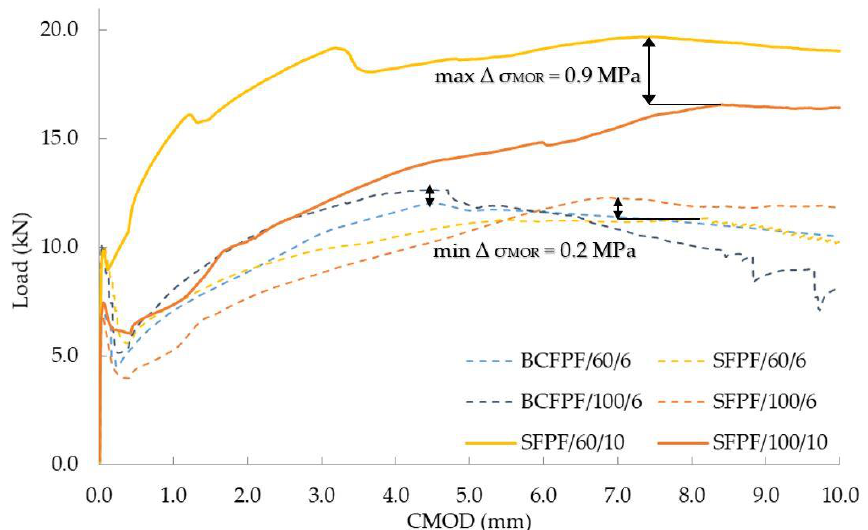
Figure 13. Load—CMOD (crack mouth opening displacement) relationship graphs showing the influence of fiber length on the obtained σ MOR stress values for fiber-reinforced soil-cement with a 450/0.8 matrix.